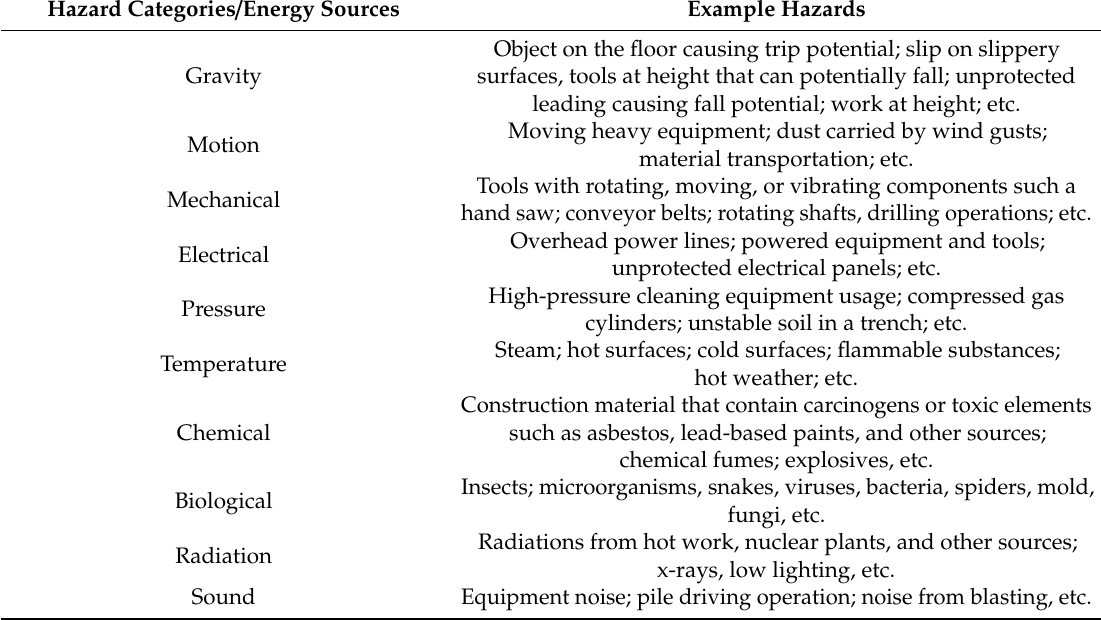
Table 1. Hazard categories based on the underlying energy sources and relevant examples. Hazard Categories / Energy